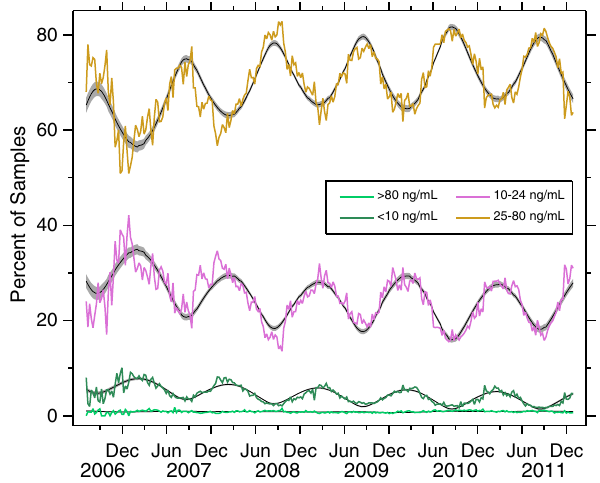
Figure 3. Time series plot of 25OHD data, four categories. Each color represents one 25OHD category, as indicated. Models (black) and 95% confidence bounds (gray) from models in table 3 are also shown. All four series total 100%.